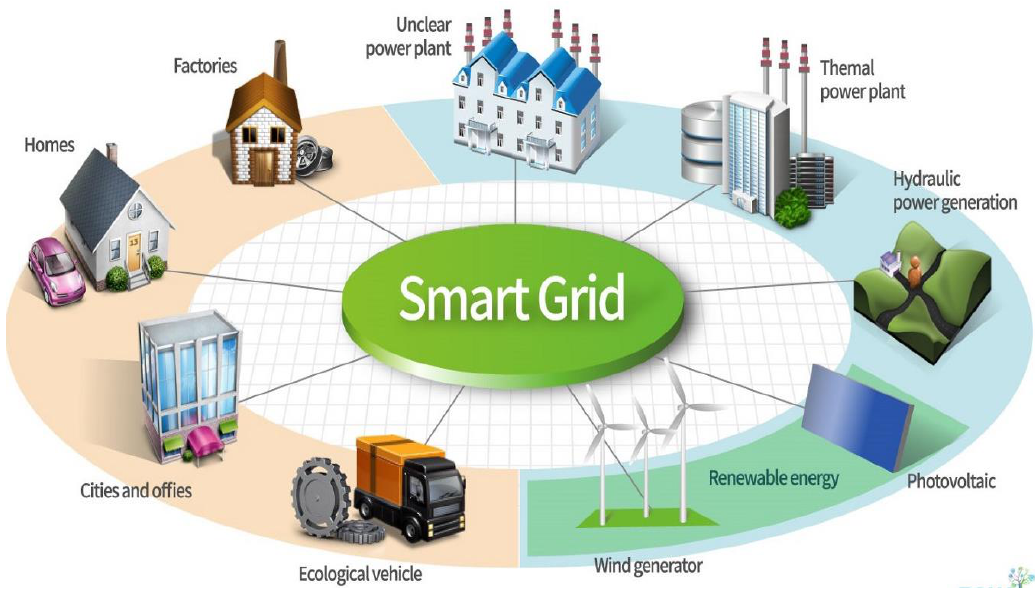
Figure 4. Modern smart grid system with Electric Vehicles (EVs) load demand.